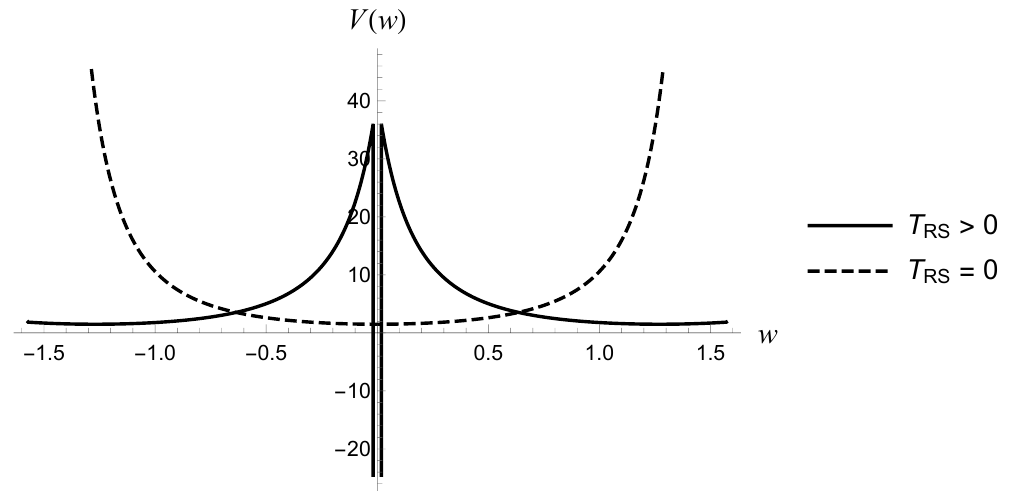
Figure 4: A sketch of the AdS volcano potential V ( w ) in [ 11 ] for d = 4, depicted as a function of a coordinate w which is normal to the brane. We show both the T > 0 case (which has a crater) and the T = 0 case (which lacks a